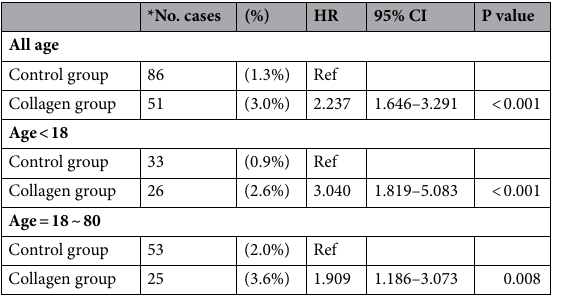
Table 2. The risk of collagen diseases group and control group in male adult civilians. *Statistical significance was set at p < 0.05